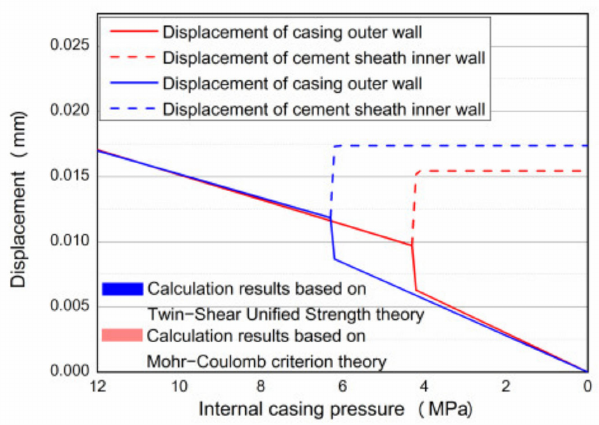
Figure 7. Change in the cement sheath micro annulus in the unloading